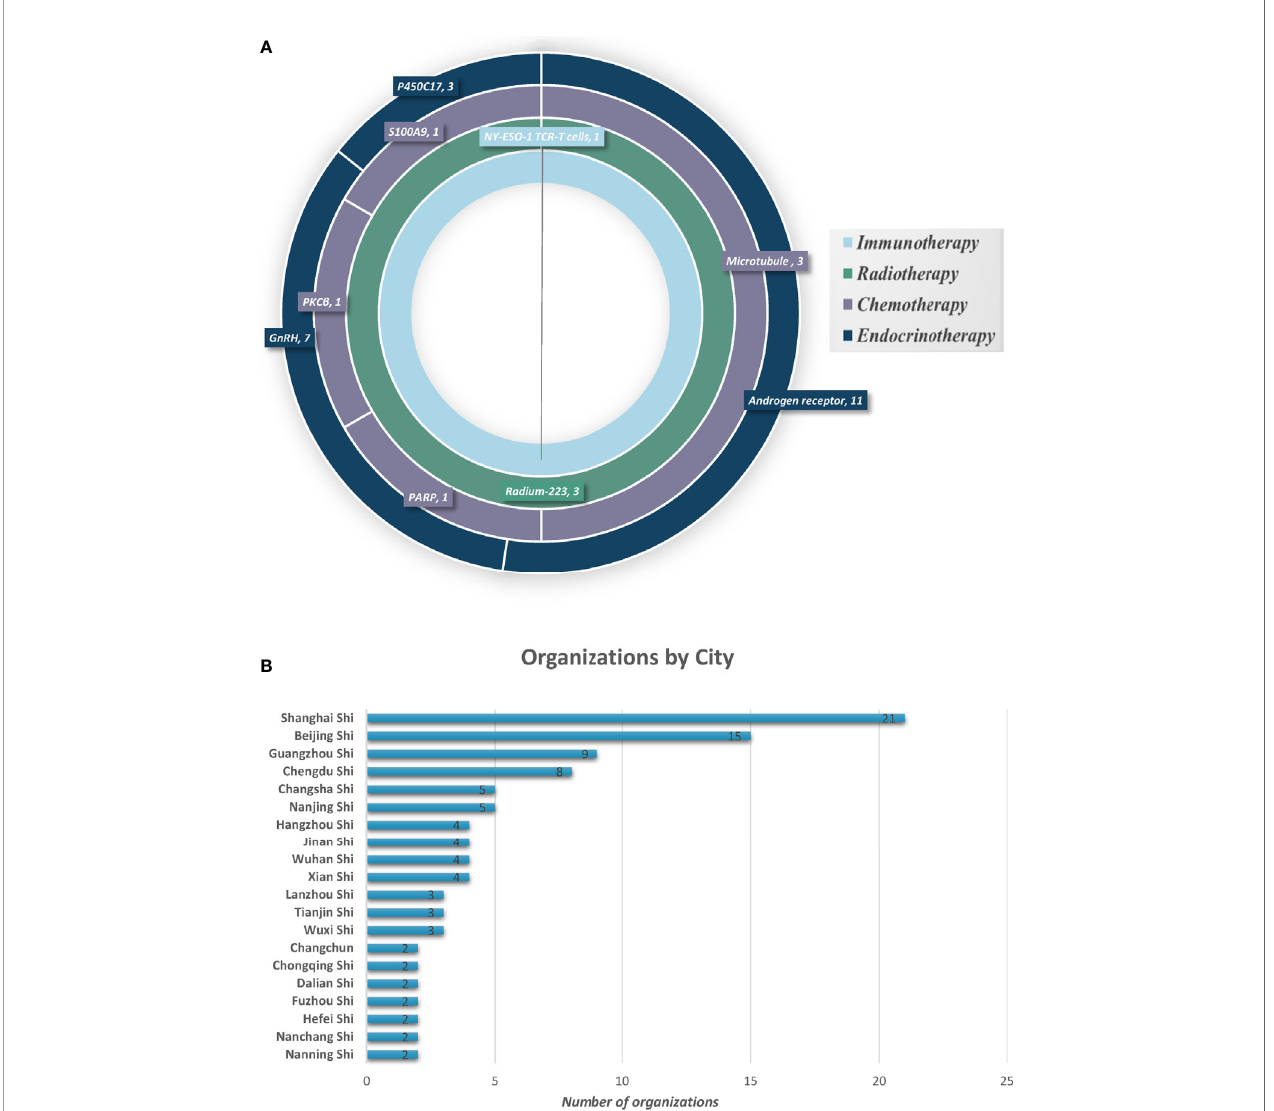
FIGURE 3 | Prostate cancer therapy trial classi fi cation and geographical locations. (A) Therapy type and targets for PC in clinical trials in mainland China. (B) Cities with organizations for PC drug clinical trials (showing top